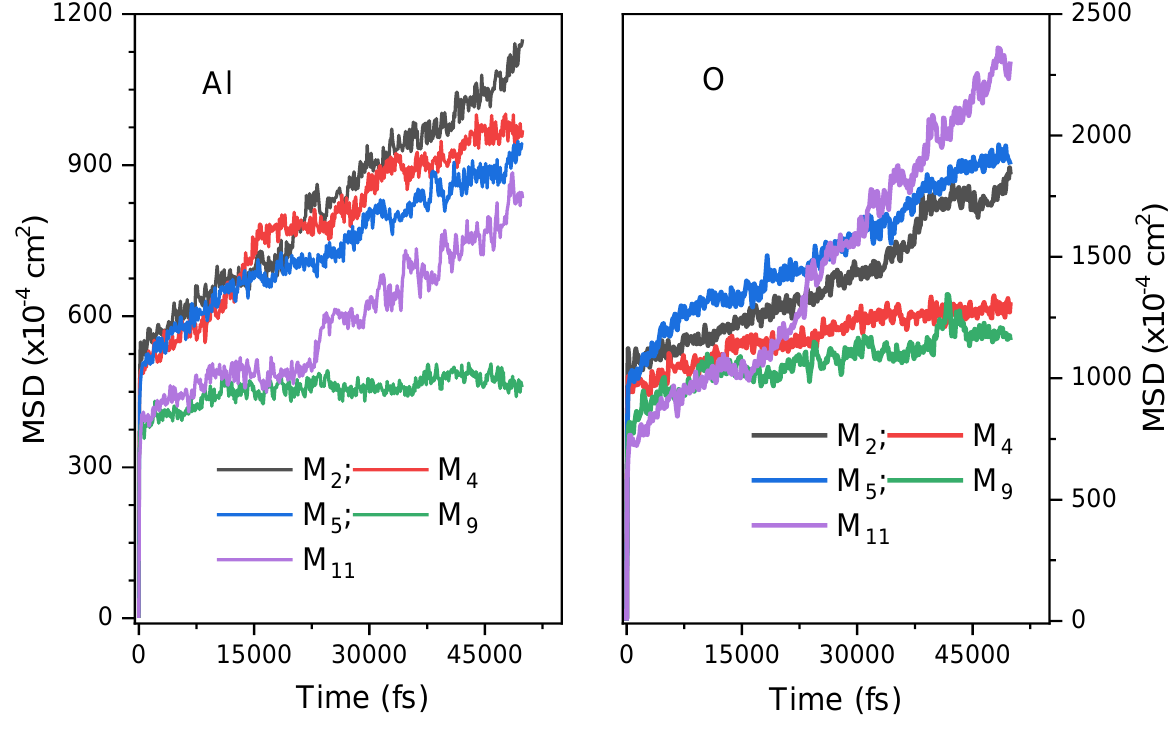
Figure 11. MSD of Al (left) and O (right) atom as a function of time at pressure of 5, 15, 20, 60 and 100